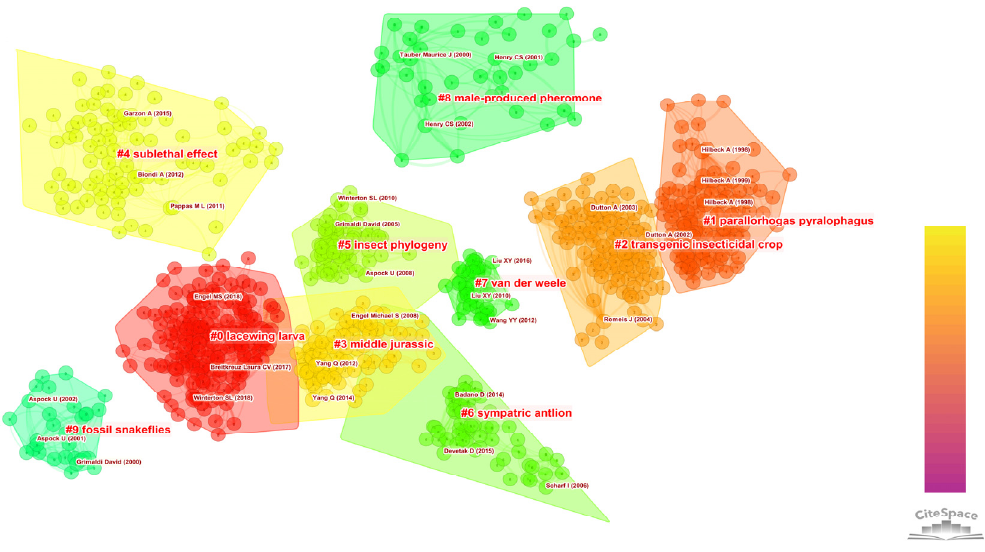
Figure 3. Cluster visualization based on a document co-citation network. The red font represents the clustering label. Different clusters have different